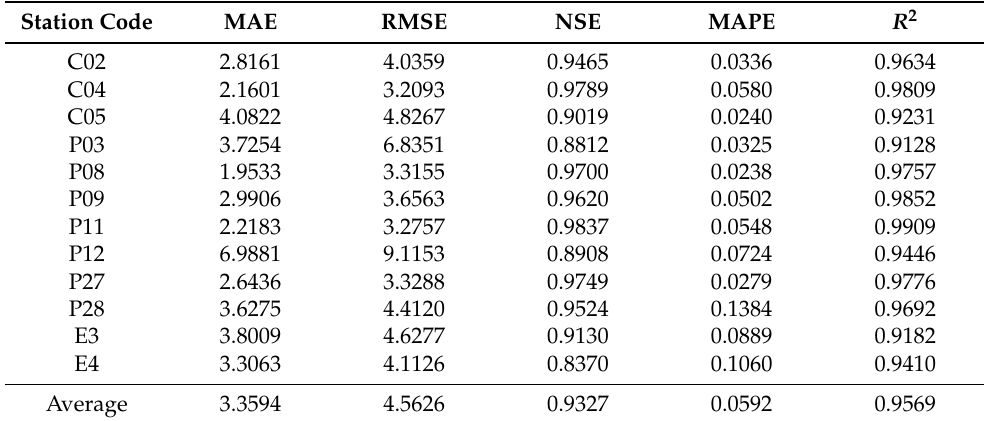
Table 4. Error metrics of the maximum recorded rainfall p max ( t d ) recorded at different durations, with respect to the estimated rainfall ˆ p max ( t d ) of the IDF curves at T = 20 years.